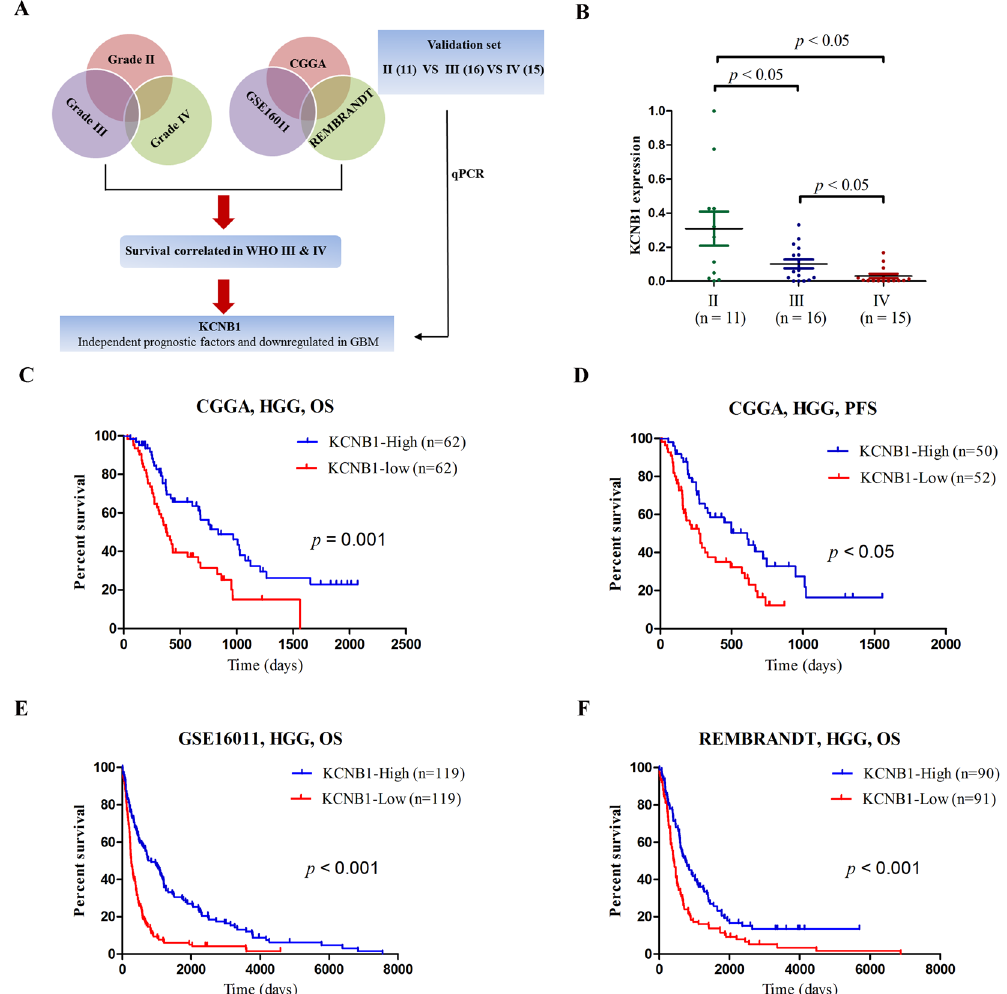
Figure 1. Discovery of a prognostic ion gene in gliomas. ( A ) Schematic strategy used to identify a prognostic ion gene in gliomas. ( B ) The qRT-PCR analysis of relative KCNB1 expression in glioma tissue samples from the validation cohort. P values were calculated with two-sided Student’s t test. ( C , D ) Kaplan–Meier OS and PFS analysis of patients with high grade (83 patients with primary GBM and 41 patients with grade III) in CGGA. Survival among KCNB1-high group (n = 62) and KCNB1-low group (n = 62) patients is shown. P values were calculated using the two-sided log-rank test. ( E , F ) Kaplan–Meier OS analysis of patients with high grade in GSE16011 (154 patients with grade IV and 84 patients with grade III) and REMBRANDT (110 patients with grade IV and 71 patients with grade III). OS, overall survival; PFS, progression-free survival. P values were calculated with a two-sided log-rank